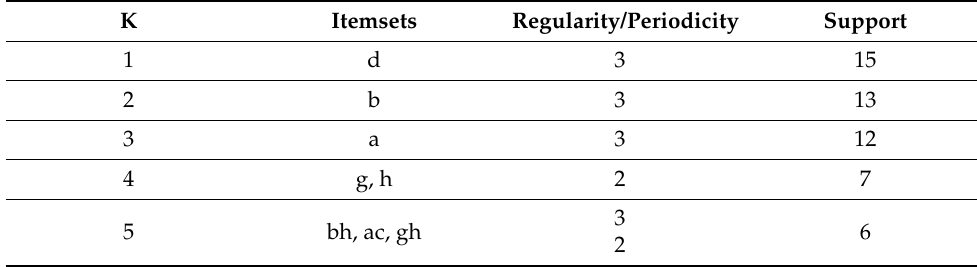
Table 6. Top-5 IFR set after mining batch A and